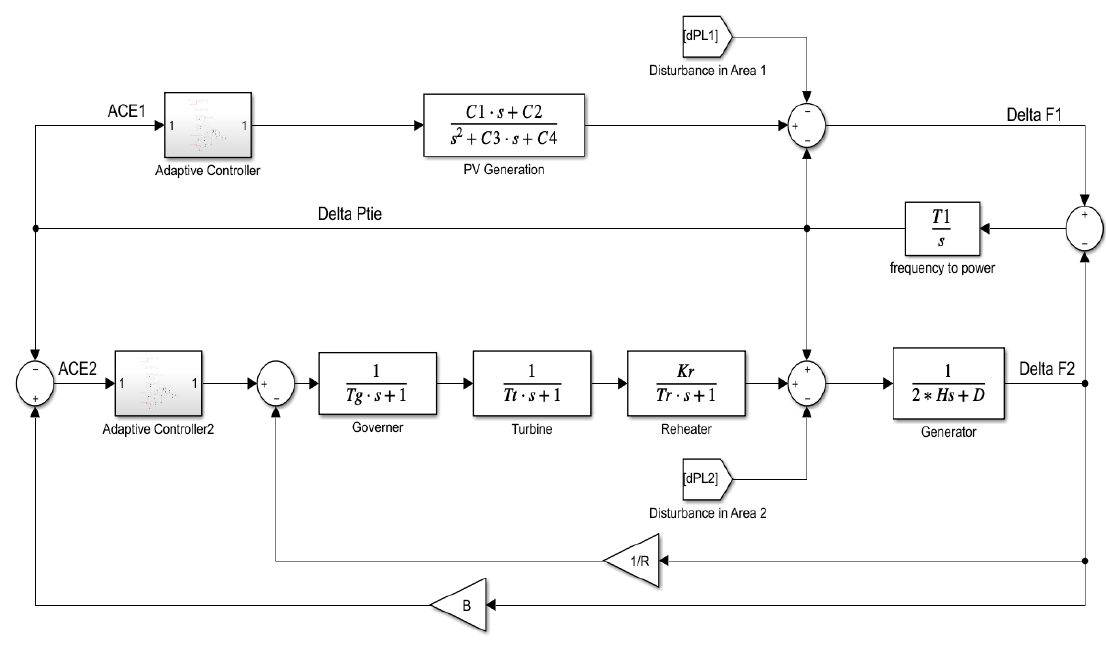
Figure 13. Hybrid PV-thermal system.